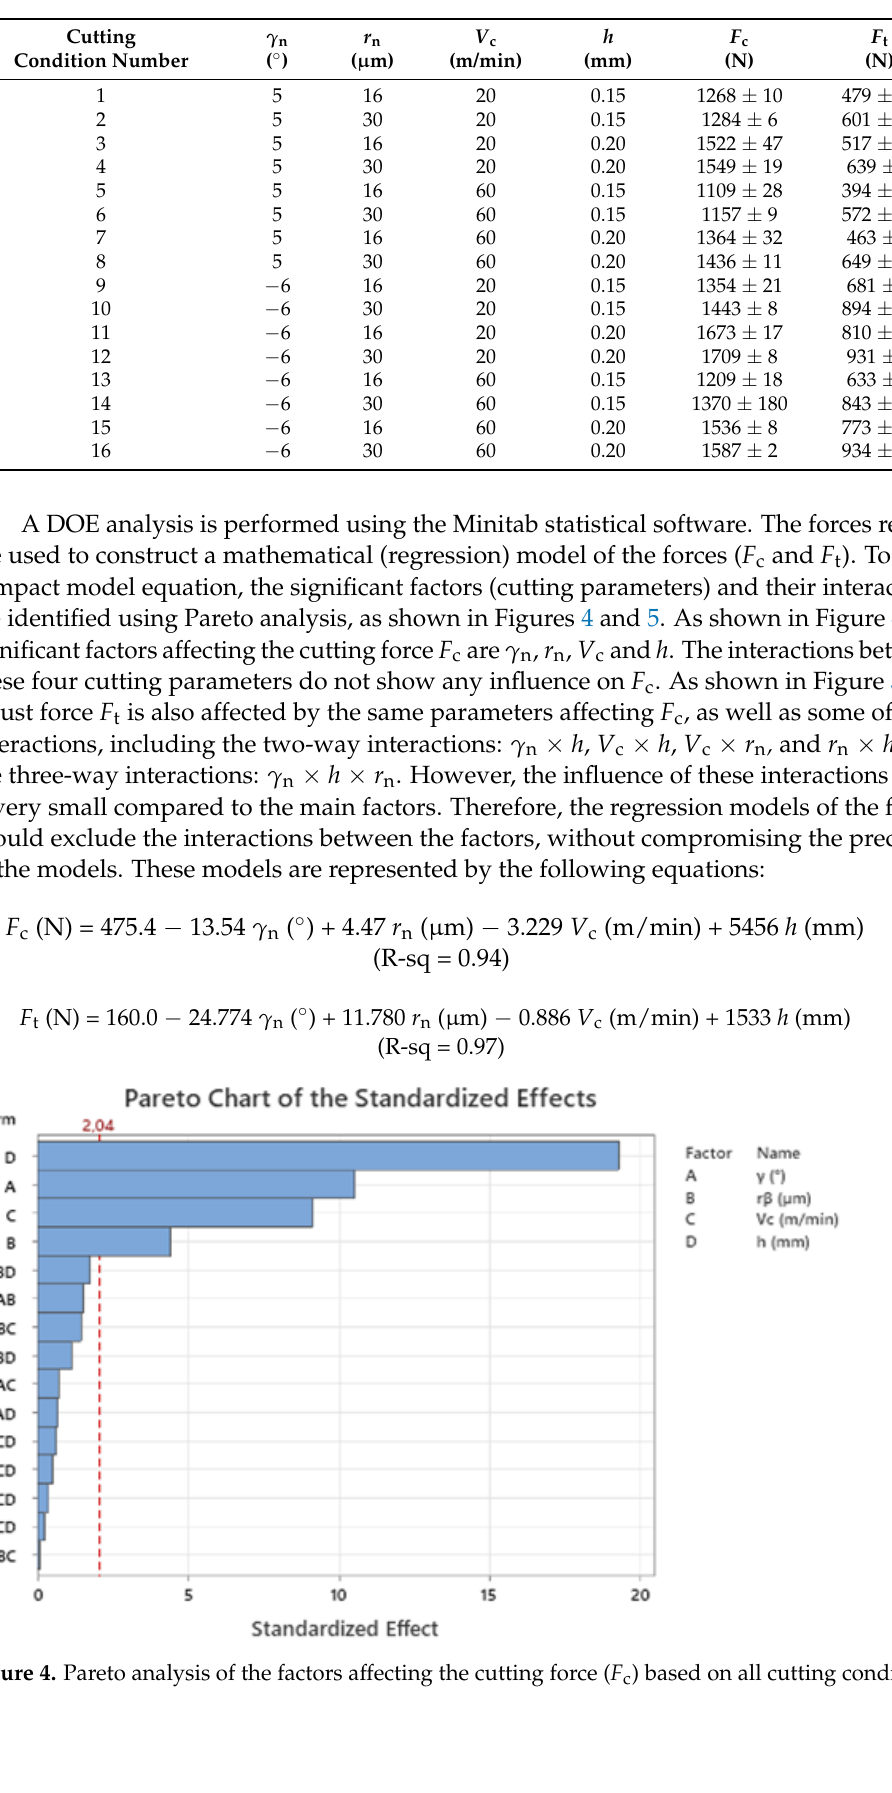
Table 4. Experimental results of cutting and thrust forces.